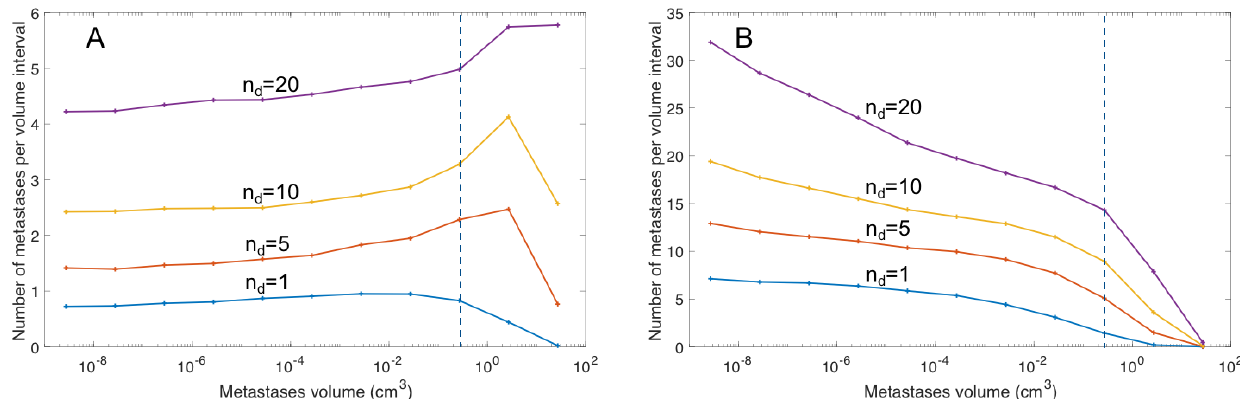
Figure 2. The metastatic distribution for different metastatic formation rates ( A ) c = 0.16% d −1 g −1 ( B ) c = 2.56% day −1 g −1 . The dashed blue line indicates the assumed detection limit of metastases, equal to 7 mm. The blue, red, yellow and magenta lines show the metastatic distribution for 1, 5, 10, and 20 detectable metastases ( n d ), respectively. Table 3. Simulation results of the number of detectable metastases for two different metastatic formation constants. For the median size of detectable metastases, the 95% confidence interval is presented in parentheses. Number of Detectable